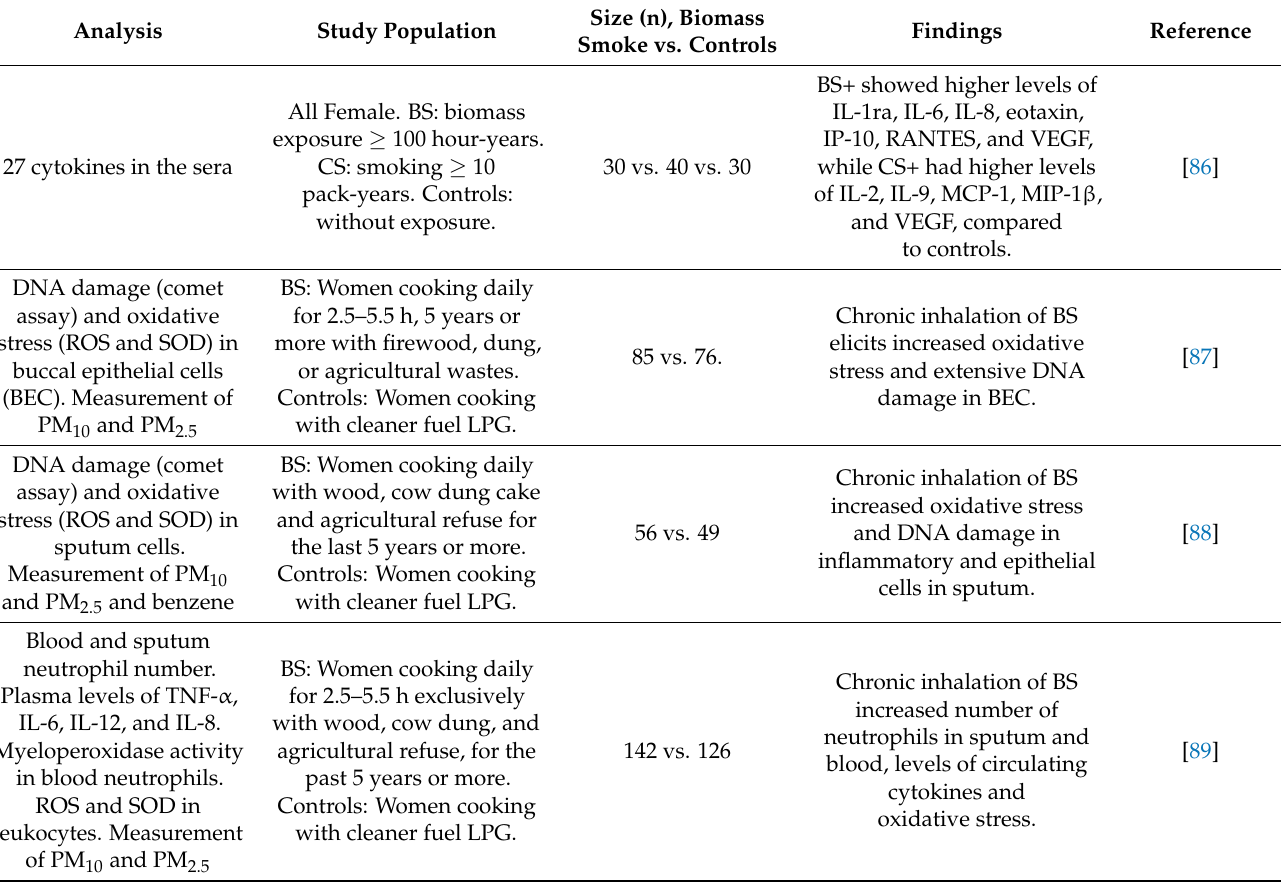
Table 2 summarizes the effects of chronic exposure to woodsmoke on healthy adults. Table 2. Summary of the studies analyzing the effects of chronic exposure to biomass smoke (BS) on healthy